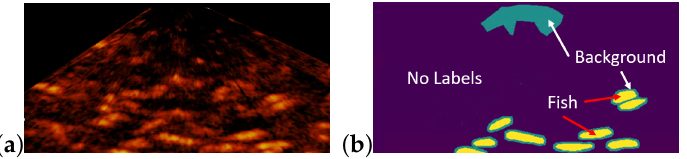
Figure 5. The sonar images of the three test environments, where ( a , b ) show the fish farms for test environments E-A,B and E-C, respectively; ( c – e ) show examples of the sonar images in test environments E-A, E-B, and E-C, respectively.